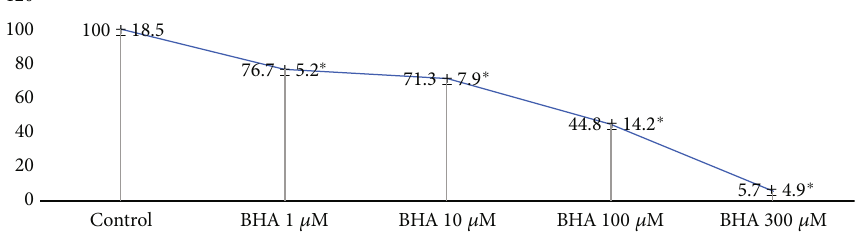
Figure 2: Cell division rate of Vero cell cultures exposed for 24 hours to BHA. Asterisks indicate statistically signi fi cant values concerning the control (ANOVA, p = 0 : 067